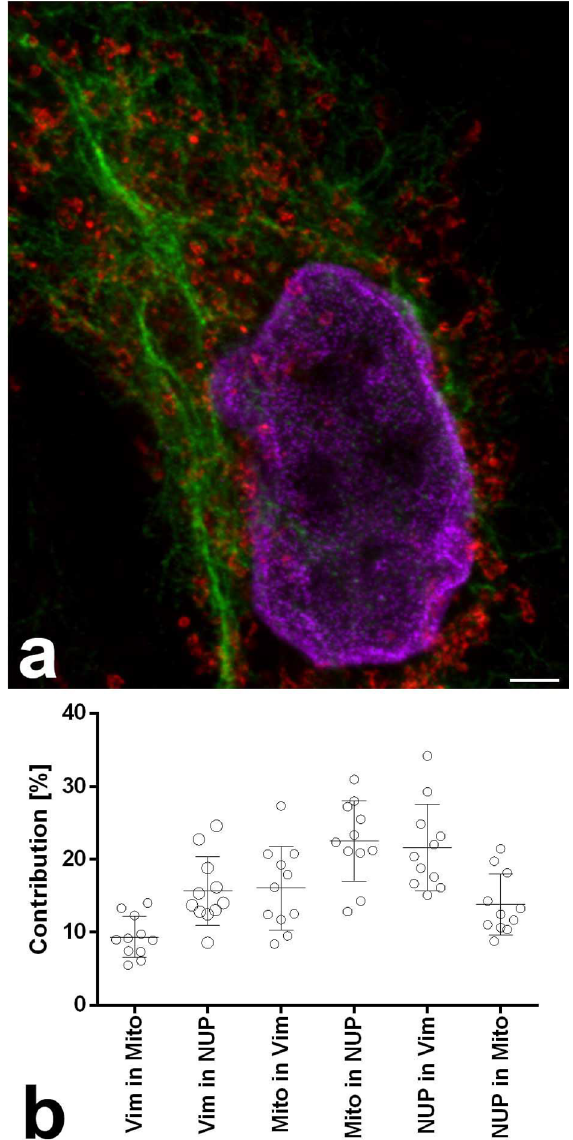
635P (red), and nuclear pores CF680R (magenta). Scale bar 2 µm. ( b ) Contribution chart, n = 11 image